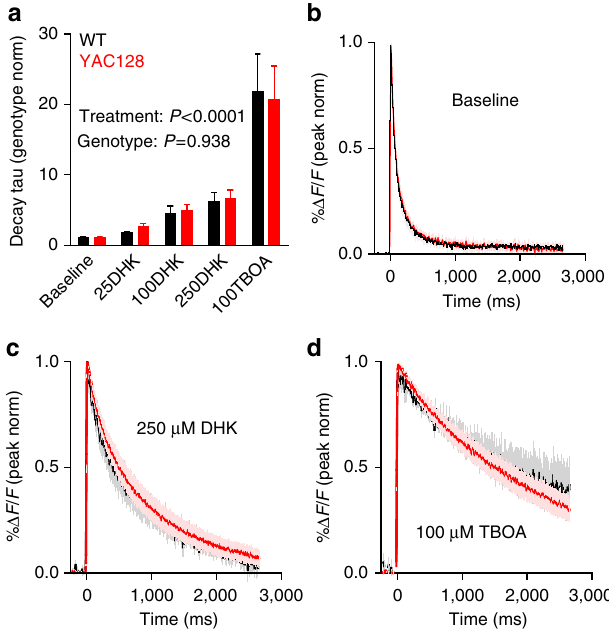
Figure 3 | Pharmacological inhibition of GLT-1 reveals no impairment of GLT-1-mediated glutamate clearance in 2-month-old YAC128 striatum. ( a ) Bar graph showing the fold-increase in iGluSnFR decay tau following a 10-min bath application of the GLT-1-specific blocker dihydrokainic acid (DHK; 25, 100 and 250 m M) or the non-selective glutamate transporter inhibitor threo- b -benzyloxyaspartic acid (TBOA; 100 m M). Responses were evoked by a single pulse (200 m A) and are normalized to the genotype average in baseline (untreated) conditions. ( b – d ) Average responses ( ± s.e.m.) for WT (black) and YAC128 (red) in baseline conditions ( b ) and after 250 m M DHK ( c ) and 100 m M TBOA ( d ). The responses are normalized (norm) to their peaks to simplify comparisons of decay kinetics.